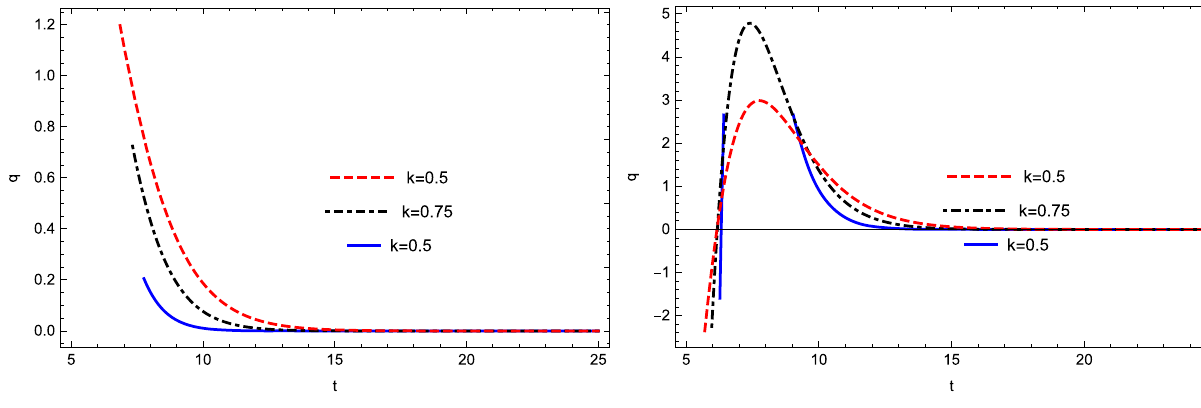
Fig. 32 Plot of q verses t for n = − 2 . 8 and n = − 3 . 8 for Bianchi type-VI model